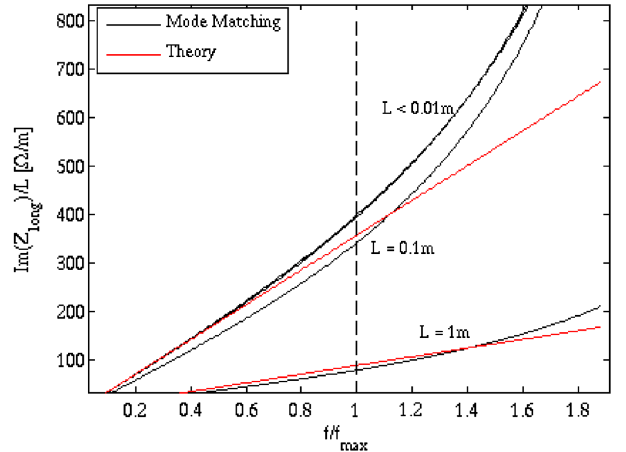
FIG. 8 (color online). Real part of impedance resonances in case of a pillbox filled with a poor conductor compared with modes expected from theory. σ ¼ 10 − 7 S = m, b ¼ 1 cm,